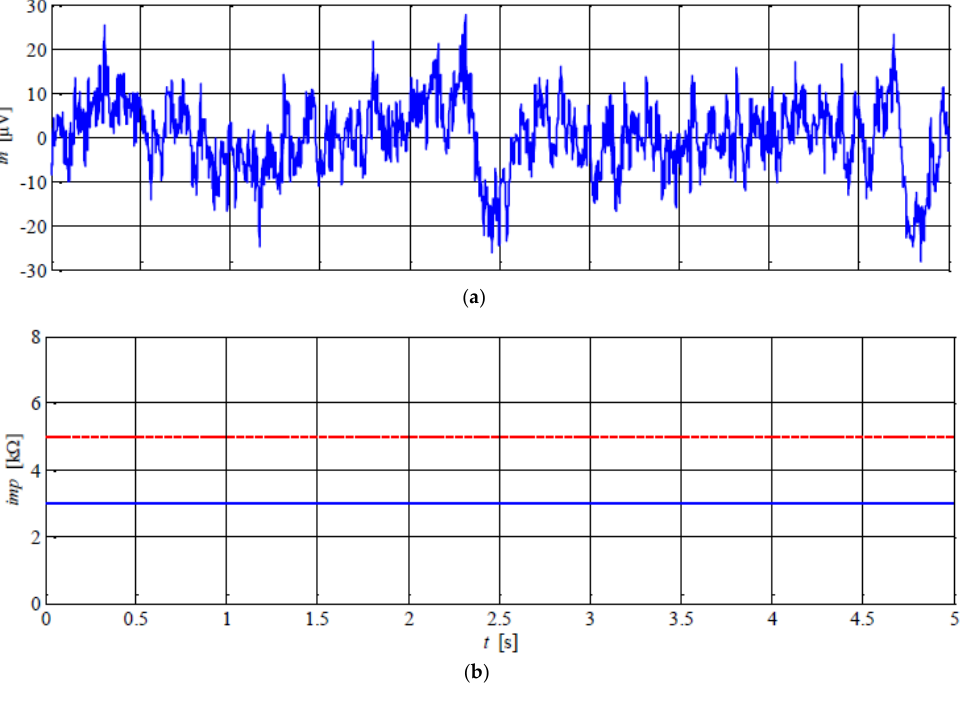
Figure 9. Time series: ( a ) EEG signal, ( b ) electrode impedance.